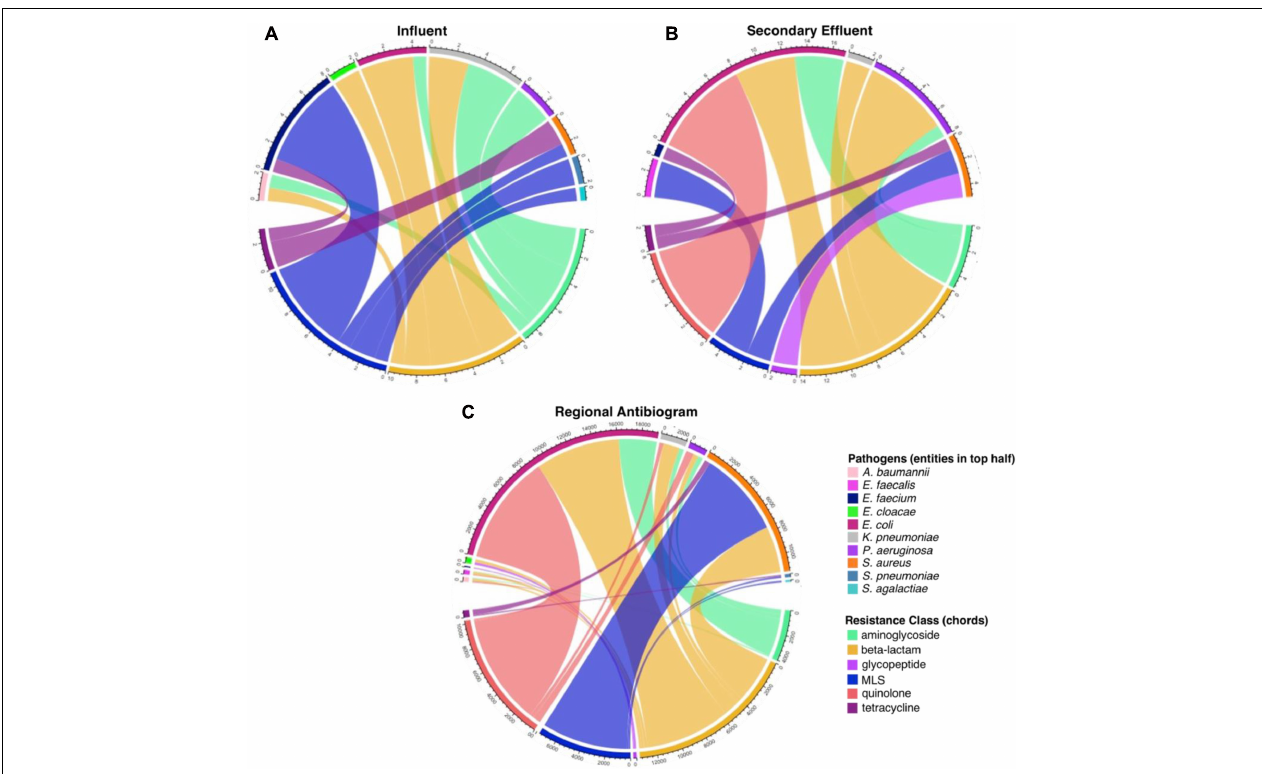
FIGURE 9 | Comparison of ARG-pathogen combinations identified in the assembled metagenomic data and in the 2017 corresponding state and regional cumulative antibiogram (Virginia Department of Health, 2017). The values on the outer rings indicate the frequency of co-occurring antibiotic resistance genes (ARGs) grouped by resistance class, mobile genetic elements (MGEs), and human pathogen-like sequences in all (A) influent and (B) secondary effluent samples ( Supplementary Data 3 ). (C) The values on the outer ring represent each antibiotic-pathogen combination which was tested in the regional antibiogram, aggregated by antibiotic resistance class (i.e., a single connection is indicative of one isolate conferring resistance to one antibiotic within a given class; Supplementary Data 4